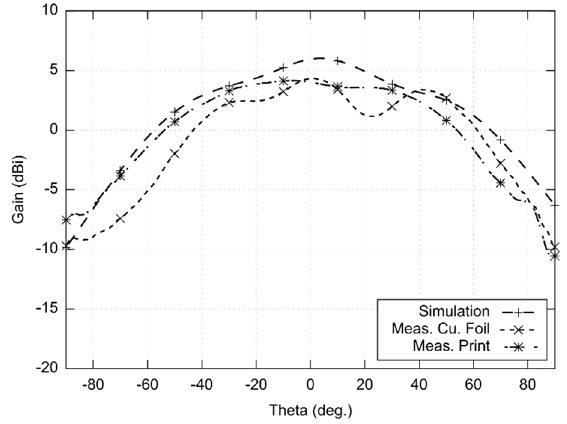
Figure 6. Simulated and measured radiation patterns (XZ plane) of the antenna designed for the 24 GHz ISM band (simulated and measured at 22.25 GHz).